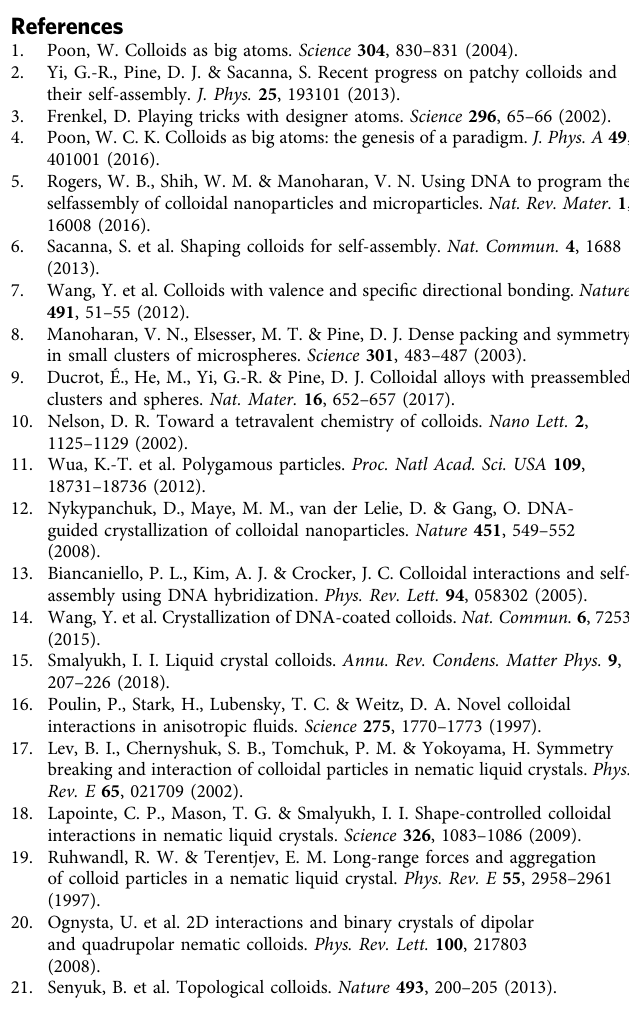
Fig. 10 Polarimetric imaging principles and setup. a , b Polarization ellipse and a Poincaré sphere for polarized light. c Experimental setup for measuring orientation and ellipticity of the polarization